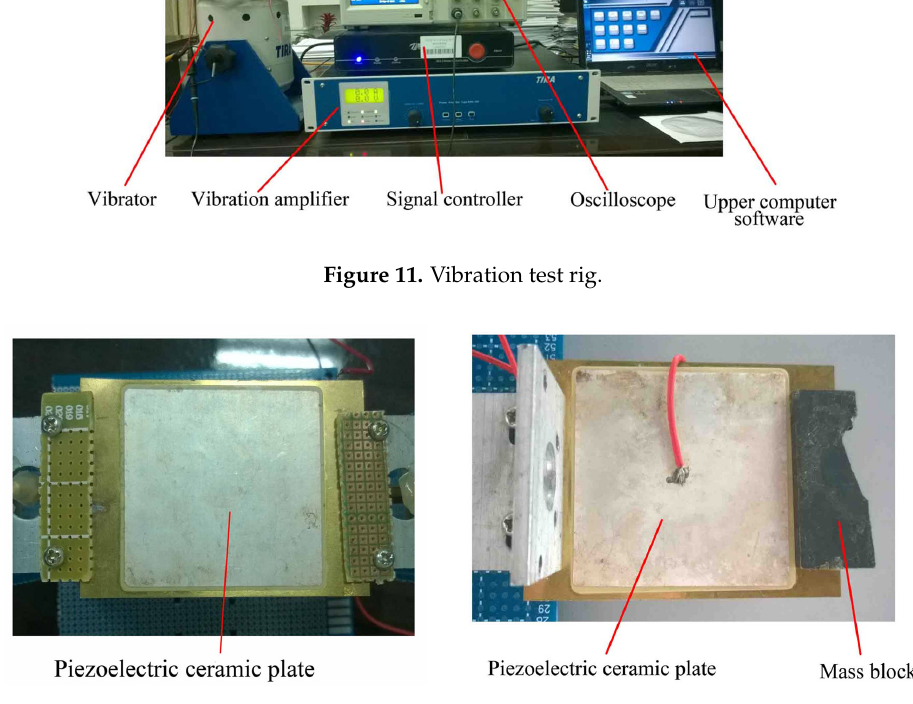
Figure 12. Piezoelectric energy harvester.